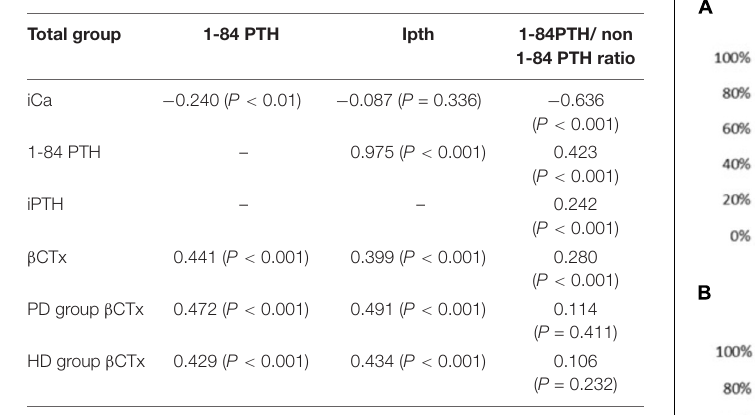
TABLE 2 | Correlations.